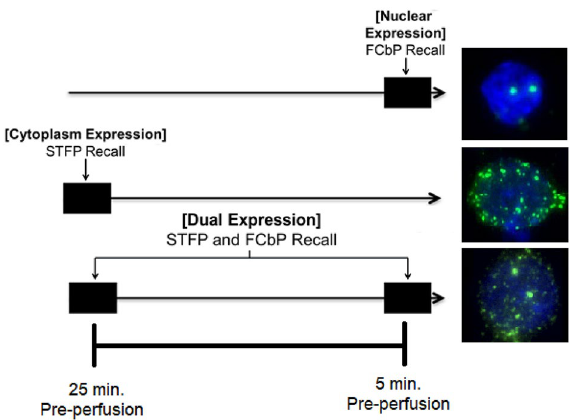
Figure 1. Patterns of Arc mRNA Expression. The above figure shows the pattern and area within a cell in which we would see Arc mRNA expression triggered by activity at the FCbP recall timepoint, the STFP recall timepoint, or activity that was triggered at both